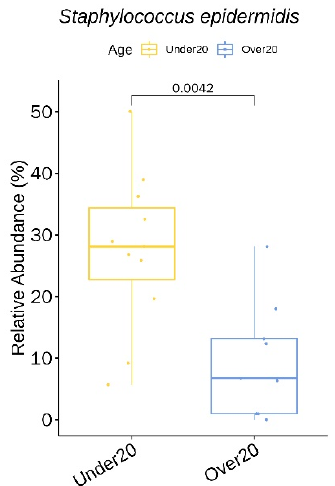
20 age group: Staphylococcus epidermidis (Figure 5), Corynebacterium matruchotii , Corynebacterium durum , Corynebacterium tuberculostearicum , Streptococcus thermophilus , Streptococcus dentisani , and Corynebacterium timonense .